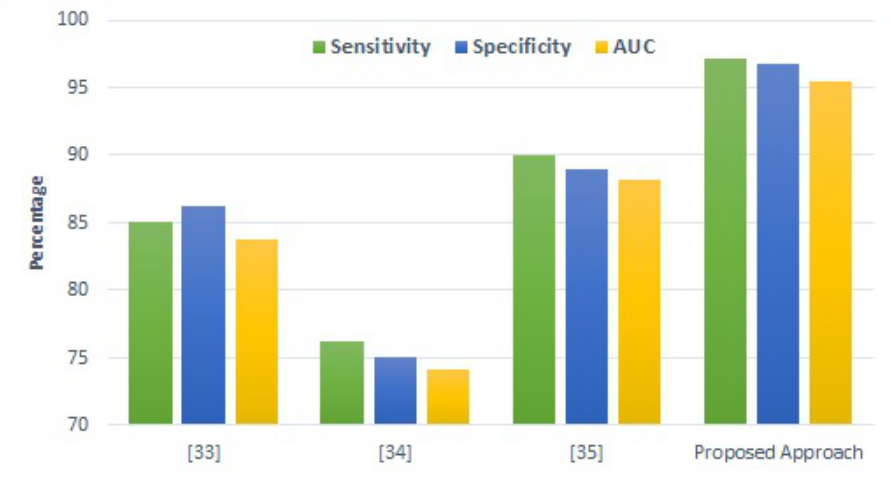
Figure 9. Performance comparison with existing state-of-the-art approaches. (Note that reference numbers in the figure are